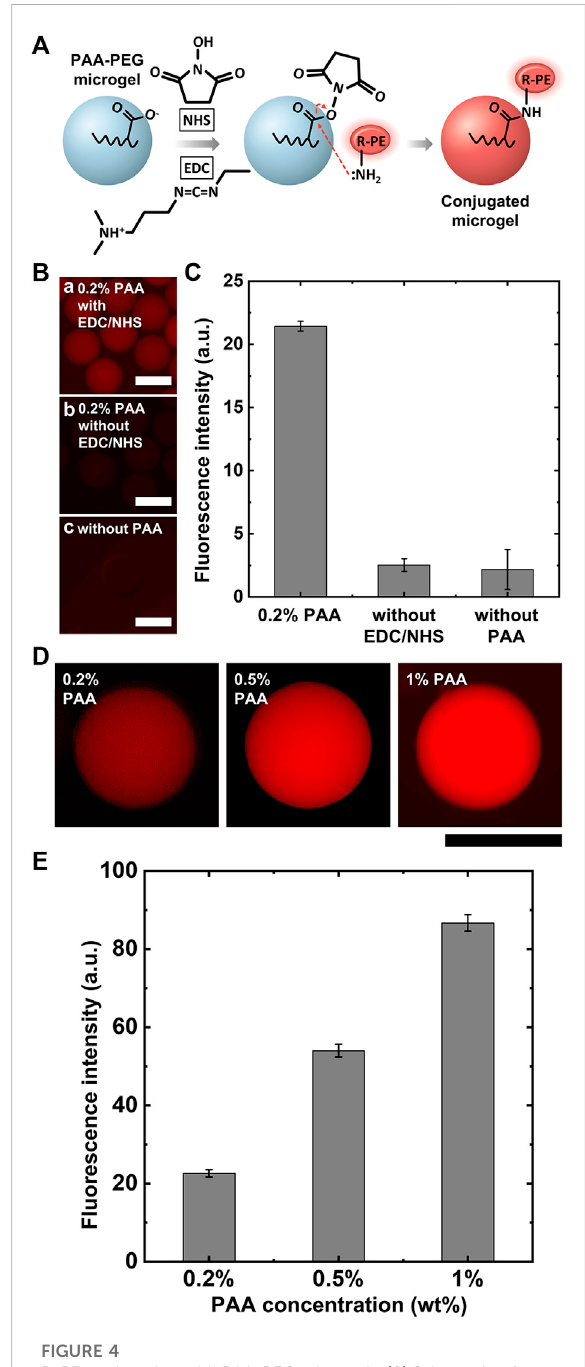
FIGURE 4 R-PE conjugation with PAA-PEG microgels. (A) Schematic of EDC/NHSreaction for R-PE conjugationwith PAA-PEG microgels. (B) Fluorescence micrographs of R-PE conjugation with PAA-PEG microgels and negative controls. (C) Plot of normalized total fl uorescence intensity for R-PE conjugation with PAA-PEG microgels and negative controls. (D) Fluorescence micrographs showing R-PE conjugation capability at varying PAA contents. (E) Plot of normalized total fl uorescence intensity for dependence on PAA contents. Scale bars represent 200 μ